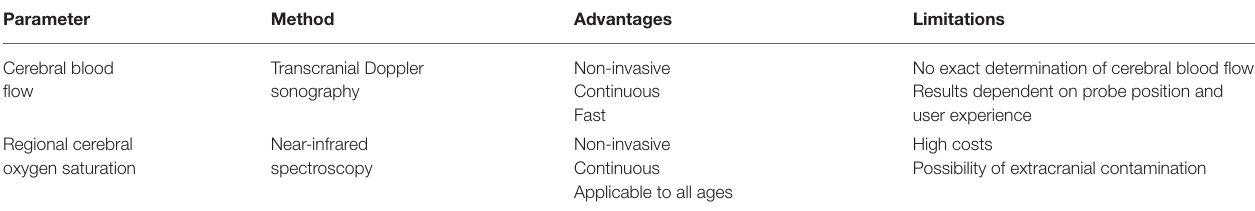
TABLE 5 | Summary of non-invasive techniques to investigate cerebral circulation.